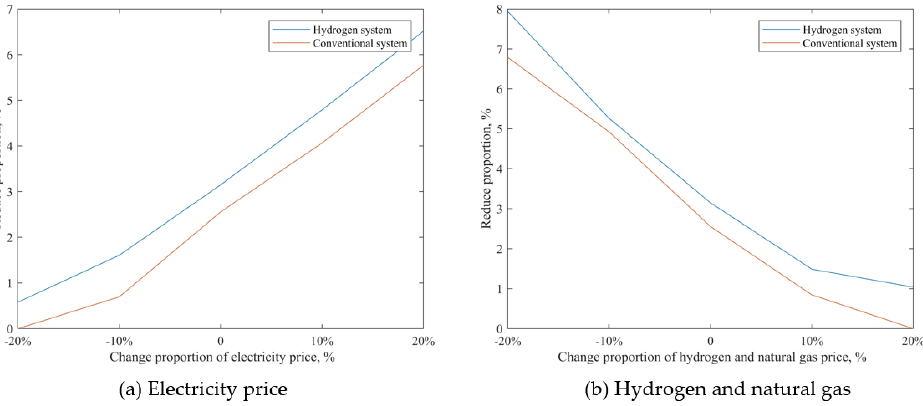
Figure 7. Sensitivity analysis of energy price (( a ) electricity price; ( b ) hydrogen and natural gas prices).